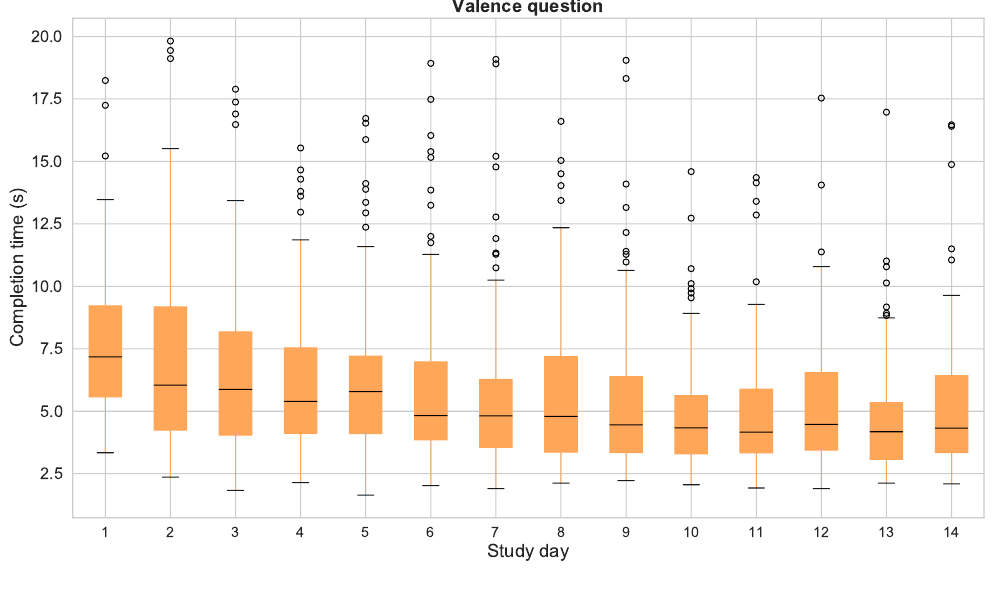
Figure 9. Completion times of the questionnaires per day of study for the valence question. Times over 300 s have not been considered.